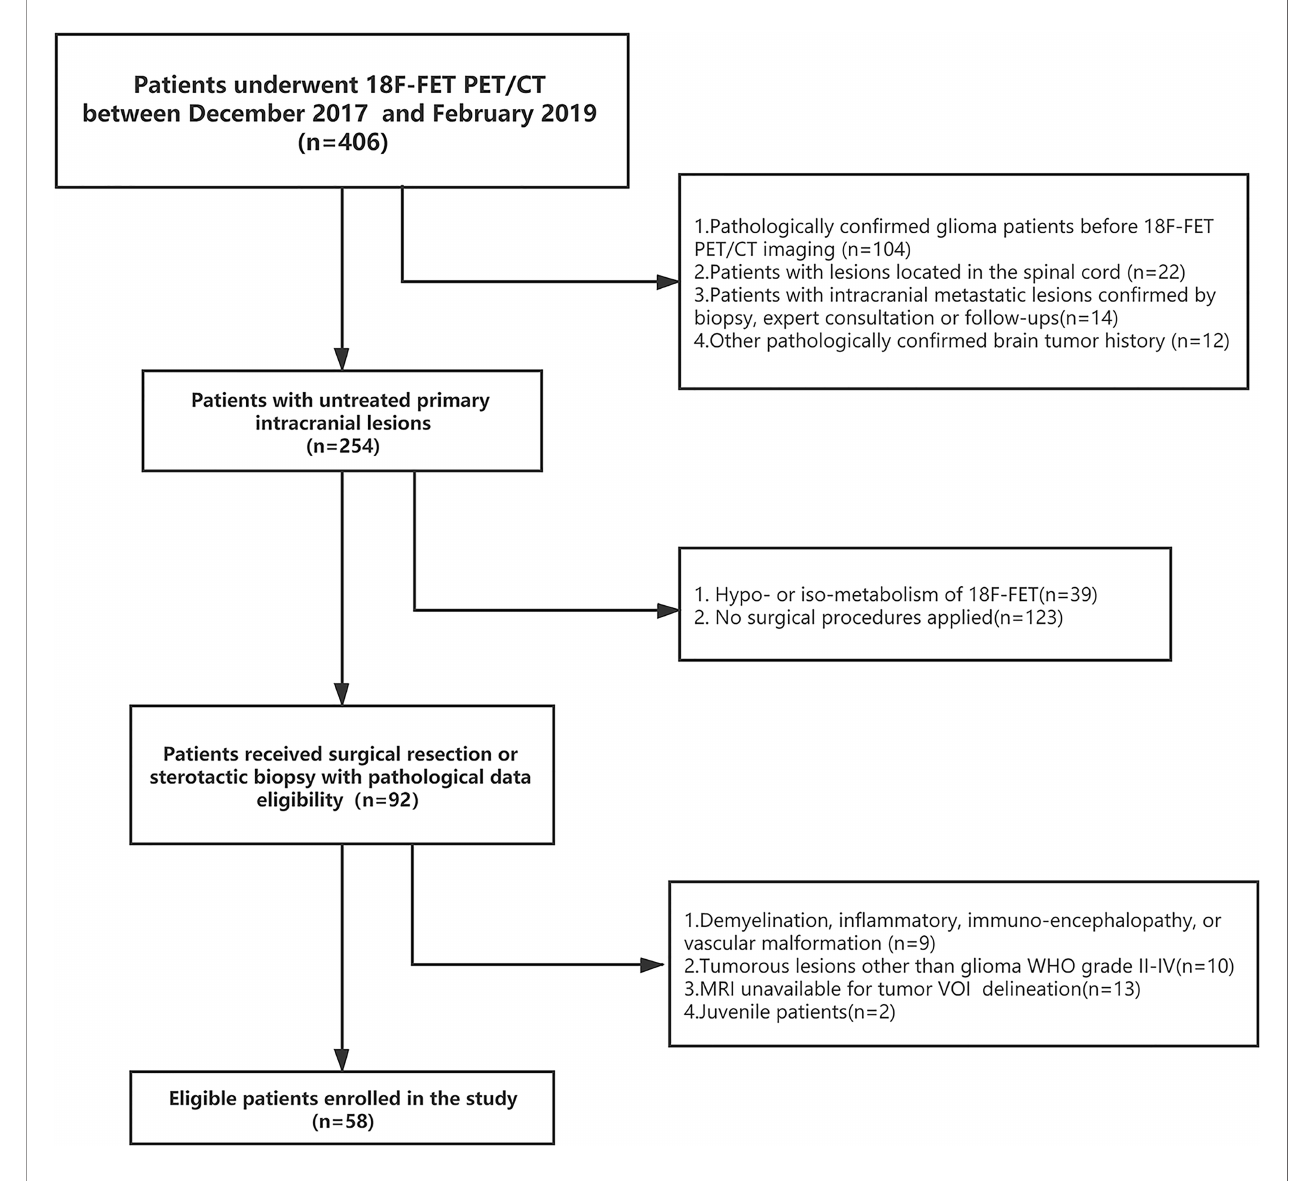
FIGURE 1 | Flow chart showing the selection criteria of enrolled